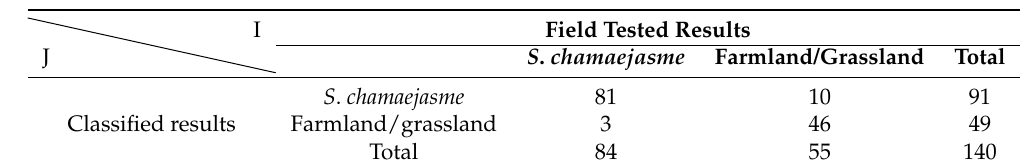
Table 3. Classification error matrix.